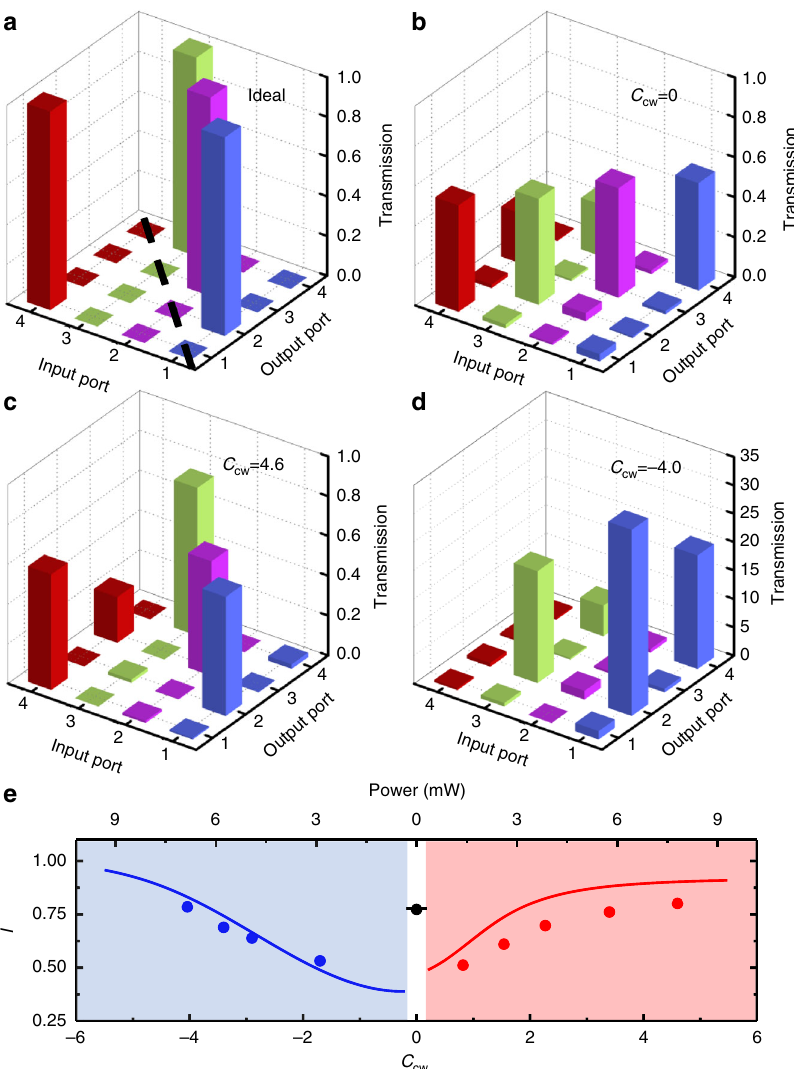
Fig. 4 Transmission matrices. a The transmission matrix of an ideal circulator: T 1 → 2 = T 2 → 3 = T 3 → 4 = T 4 → 1 = 1, and all remaining matrix elements are 0. A circulator requires an asymmetric transmission matrix with regard to the dashed line, which breaks the reciprocity. Conversely, b shows a symmetric transmission matrix measured without a control fi eld, representing a reciprocal device. c , d Transmission matrices for the demonstrated circulator and directional ampli fi er, respectively. The control power is 7.8 mW for the circulator and 6.9 mW for the directional ampli fi er, corresponding to C cw = 4.6 and − 4.0. The values of all transmission matrices are provided in Supplementary Tables 1 and 2. e Identical I of the circulator, directional ampli fi er and add – drop fi lter as a function of C cw . The lines are the results of theoretical calculations based on the parameters κ /2 π = 16.2 MHz, ω m /2 π = 90.47 MHz, and γ /2 π = 22 kHz. See Supplementary Note 2 for more details of